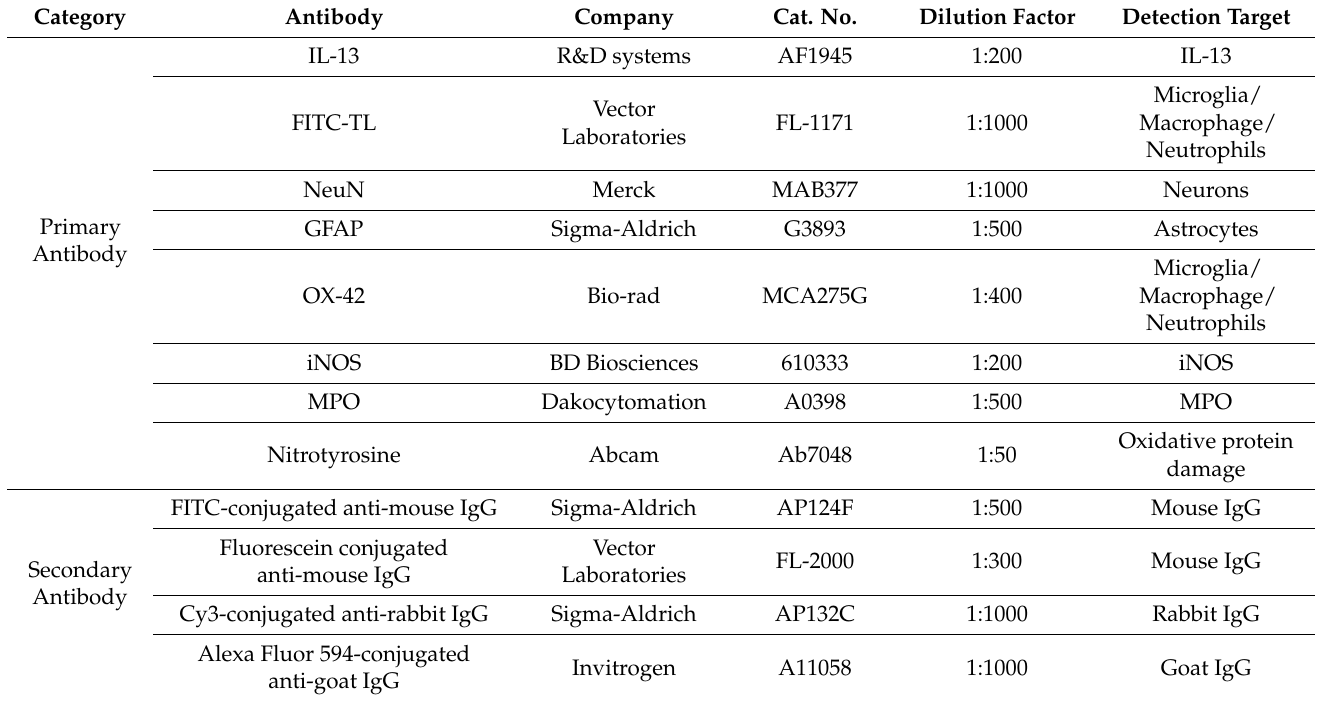
Table 2. Antibodies used for immunofluorescence staining